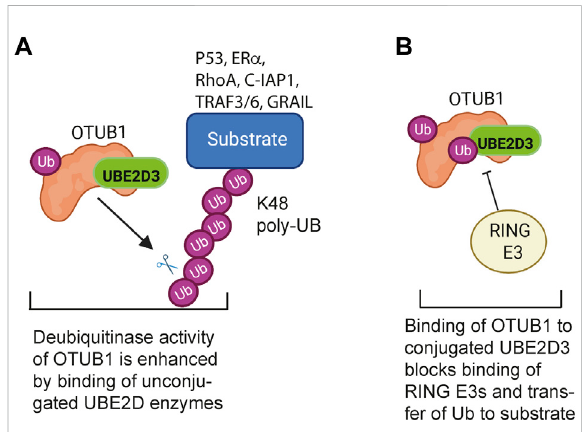
FIGURE 3 Regulatory interactions between the UBE2D enzymes and the deubiquitinase OTUB1. (A) Canonical regulation of ubiquitination by OTUB1: The deubiquitinase activity of OTUB1 is speci fi c for K48-linked polyubiquitin chains and is potentiated by binding of a number of unconjugated E2 enzymes, including UBE2D3. OTUB1 antagonises K48-linked polyubiquitination and degradation of substrate proteins that regulate cell proliferation, apoptosis, TNF signalling and T cell immune responses. (B) Non-canonical inhibition of ubiquitination by OTUB1: Binding of ubiquitin-conjugated UBE2D3 to OTUB1 blocks binding of RING E3 ligases to UBE2D3, preventing the E2 from functioning as a ubiquitin donor. OTUB1 has a similar inhibitory effect on UBE2N (UBC13). Binding of unconjugated ubiquitin to OTUB1 is potentiated by binding of free ubiquitin to a second, distal, site. Figure created with